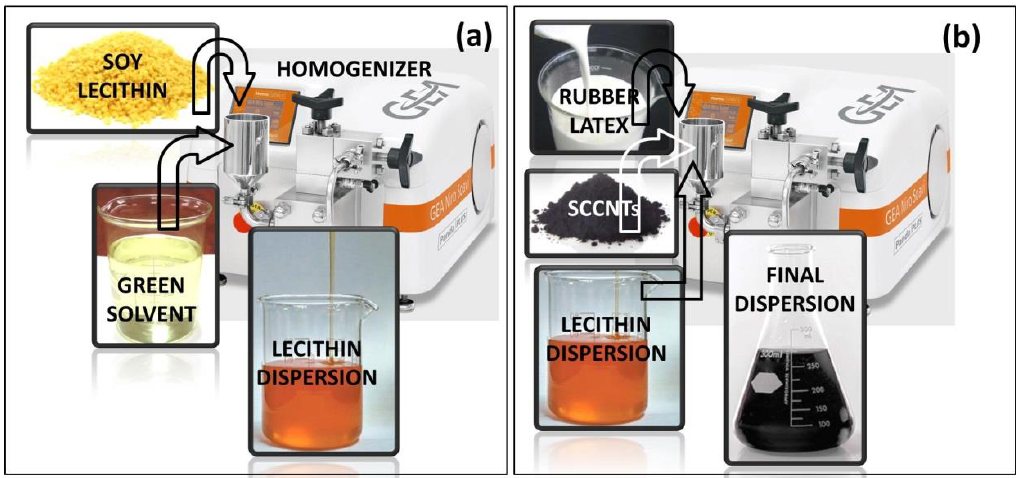
Figure 2. Schematic representation of high-pressure homogenization of soy lecithin in methyl isobutyl ketone (MIBK) ( a ) and blending of lecithin dispersion with SCCNTs and natural rubber ( b ).